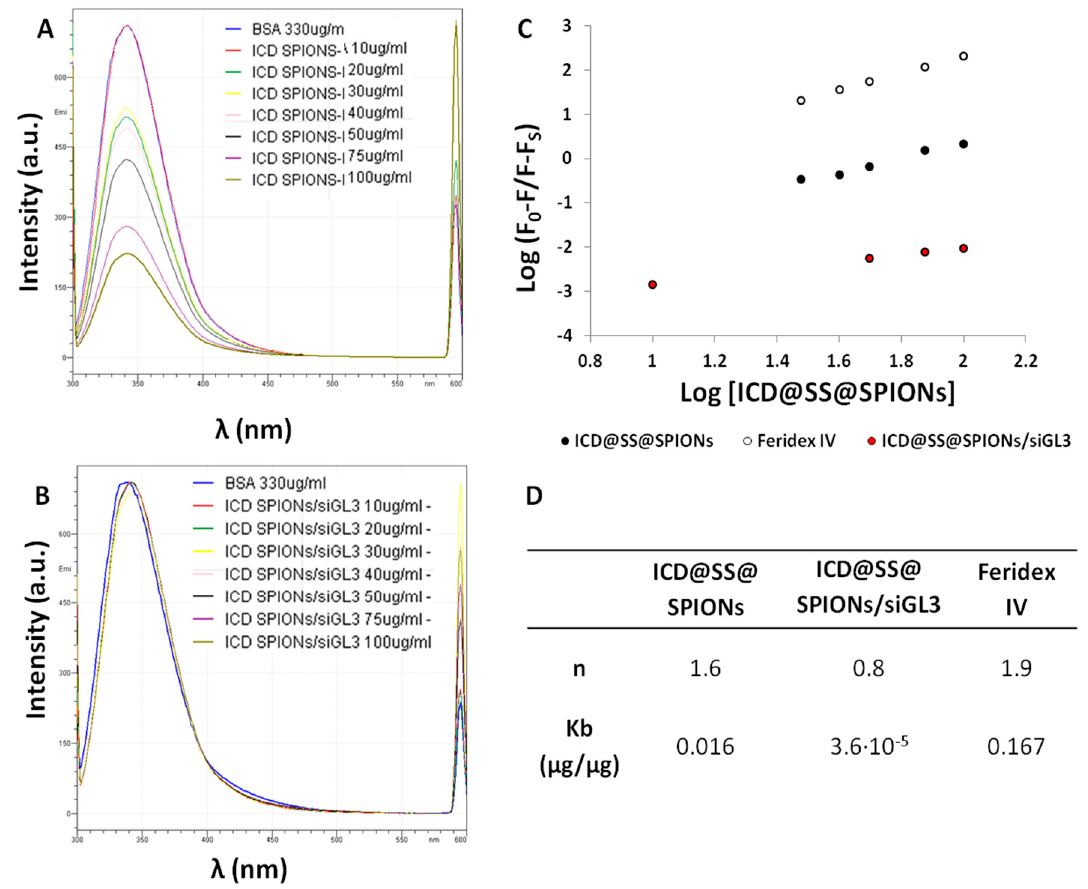
Figure 8. BSA binding on ICD@SS@SPIONs and ICD@SS@SPIONs/siRNA. Representative